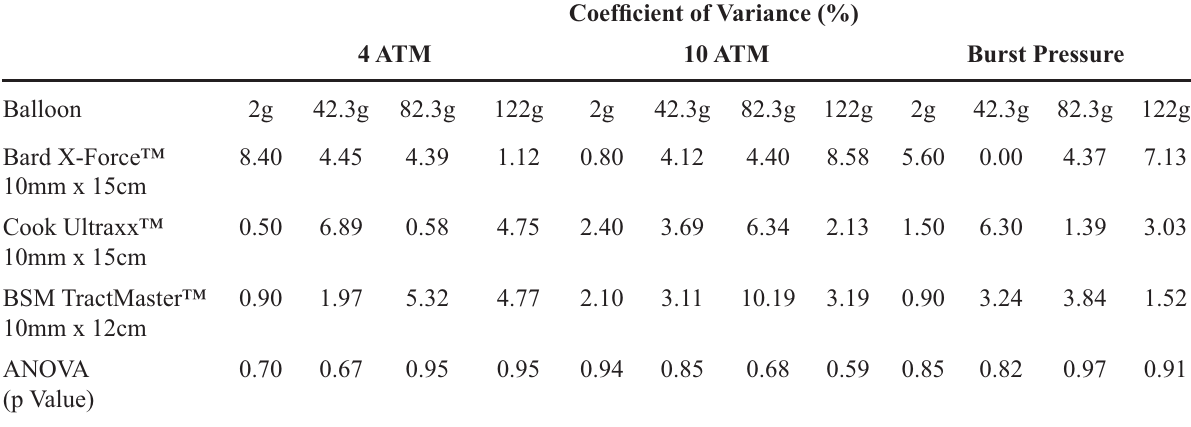
Table 2 – (cid:3)(cid:36)(cid:89)(cid:72)(cid:85)(cid:68)(cid:74)(cid:72)(cid:3)(cid:70)(cid:82)(cid:72)(cid:73)(cid:191)(cid:70)(cid:76)(cid:72)(cid:81)(cid:87)(cid:3)(cid:82)(cid:73)(cid:3)(cid:89)(cid:68)(cid:85)(cid:76)(cid:68)(cid:81)(cid:70)(cid:72)(cid:3)(cid:11)(cid:38)(cid:57)(cid:15)(cid:3)(cid:8)(cid:12)(cid:3)(cid:68)(cid:87)(cid:3)(cid:23)(cid:3)(cid:36)(cid:55)(cid:48)(cid:15)(cid:3)(cid:20)(cid:19)(cid:3)(cid:36)(cid:55)(cid:48)(cid:3)(cid:68)(cid:81)(cid:71)(cid:3)(cid:69)(cid:88)(cid:85)(cid:86)(cid:87)(cid:3)(cid:83)(cid:85)(cid:72)(cid:86)(cid:86)(cid:88)(cid:85)(cid:72)(cid:3)(cid:73)(cid:82)(cid:85)(cid:3)(cid:72)(cid:68)(cid:70)(cid:75)(cid:3)(cid:70)(cid:82)(cid:81)(cid:86)(cid:87)(cid:85)(cid:76)(cid:70)(cid:87)(cid:76)(cid:89)(cid:72)(cid:3)(cid:79)(cid:82)(cid:68)(cid:71)(cid:3)(cid:68)(cid:81)(cid:71)(cid:3) ANOVA comparisons.